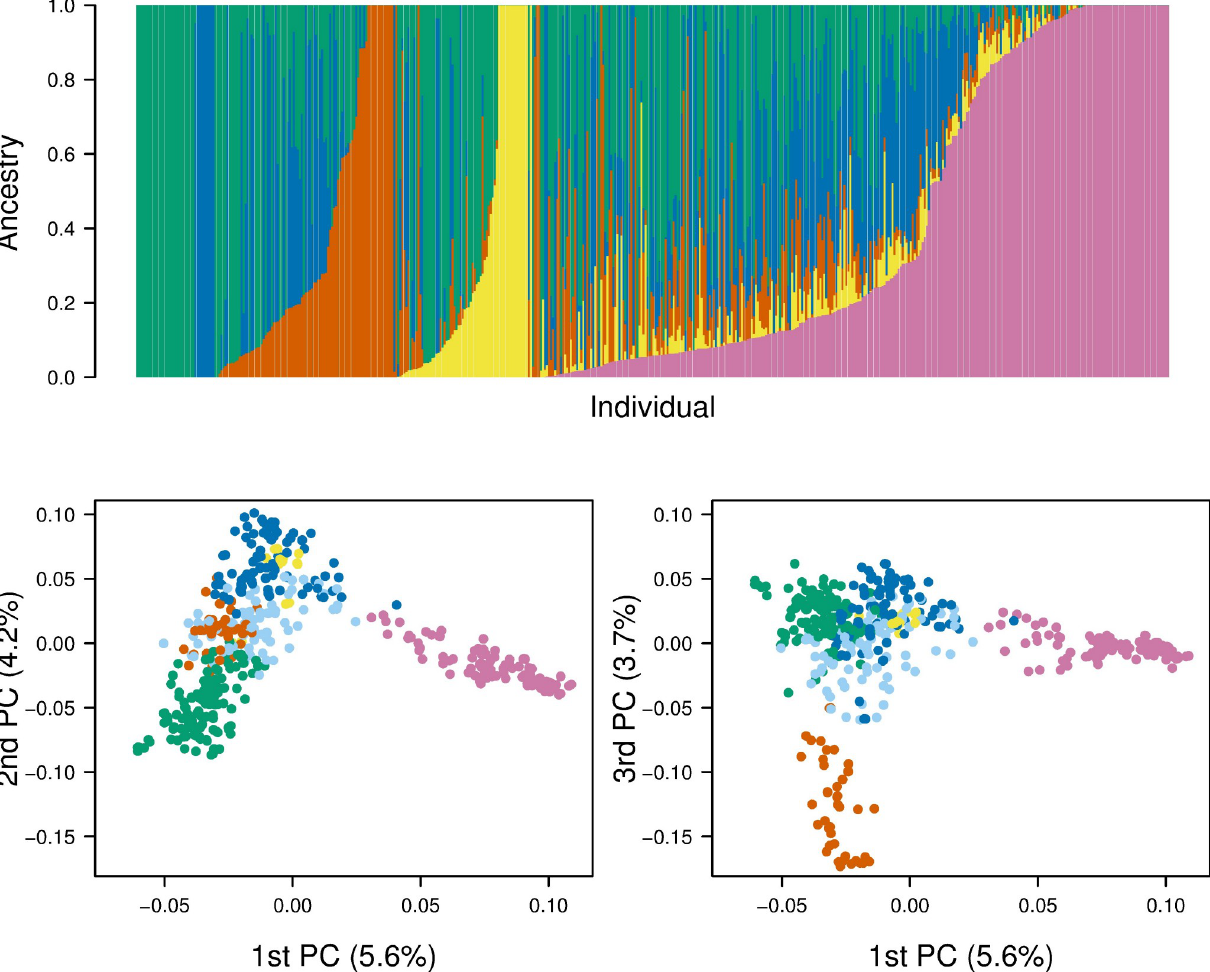
Fig 1. Genetic structure of the diversity panel. A—the ancestral fractions estimated for each accession in software ADMIXTURE for the number of ancestral populations K = 5, indicated with five colors. B—the results of the principal component analysis of the genotyping data, superimposed colors indicate the dominant ancestral fraction of the genotypes (value � 0.5) and are equivalent to the colors used in A, except for light blue which indicates the genotypes for which no ancestral fraction was dominant.